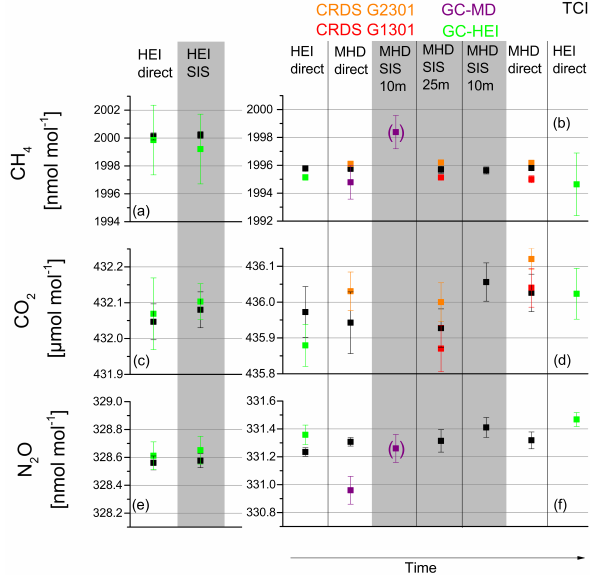
Figure 3. Direct cylinder gas measurement (direct) and SIS test on the 12 January 2013 for (a) CH 4 , (c) CO 2 and (e) N 2 O in Heidel- berg (HEI) and on the 26/27 February 2013 for (b) CH 4 , (d) CO 2 and (f) N 2 O at Mace Head (MHD). Different cylinders were used for the SIS test in Heidelberg and Mace Head. Grey shaded areas show results when the cylinder was measured via the SIS. The SIS measurement of the GC-MD did not reach a stable value. The error bars given here are the reproducibility of direct measurements or the standard deviation during the SIS test,